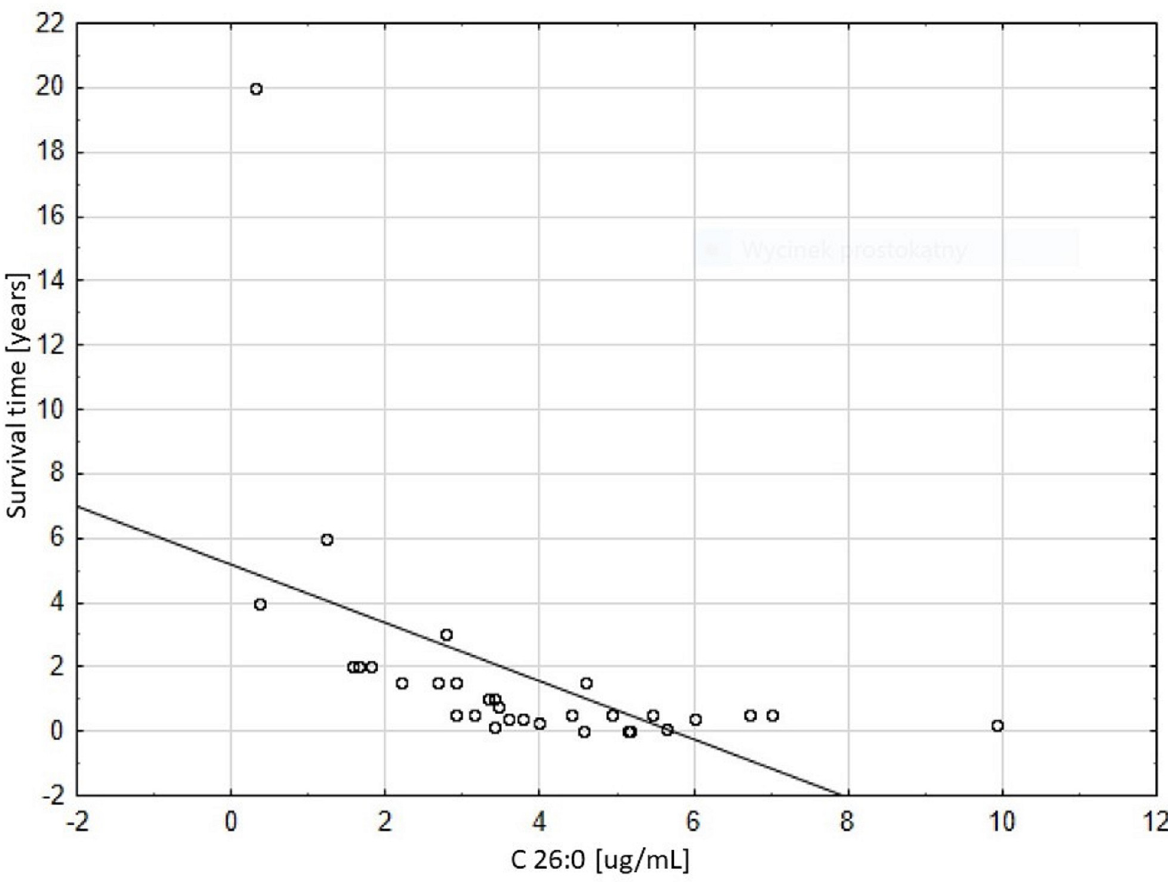
Fig 2. Dependence of the survival time on C26:0 level (Spearman rank correlation is statistically significant, R = -0.762).